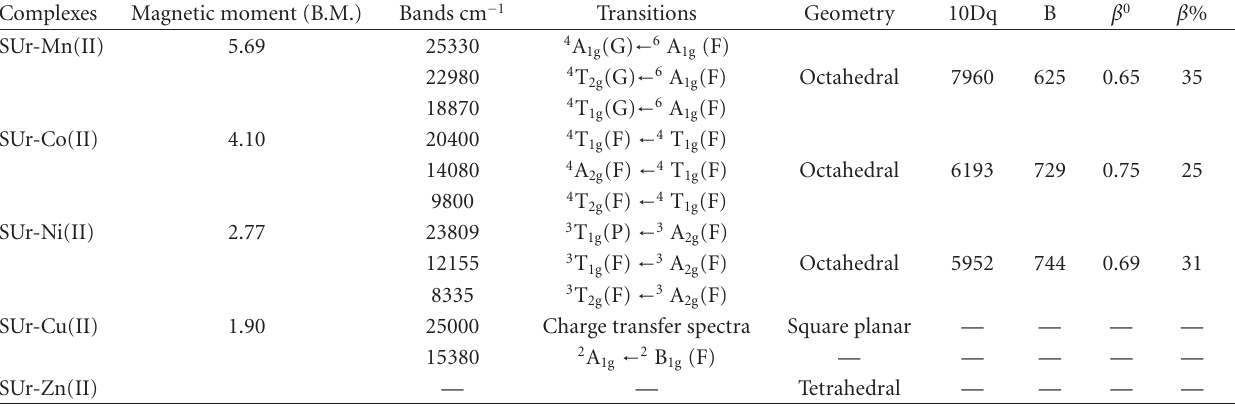
Table 5: Electronic spectral bands and magnetic moment measurements of polymer metal complexes. Complexes Magnetic moment (B.M.)